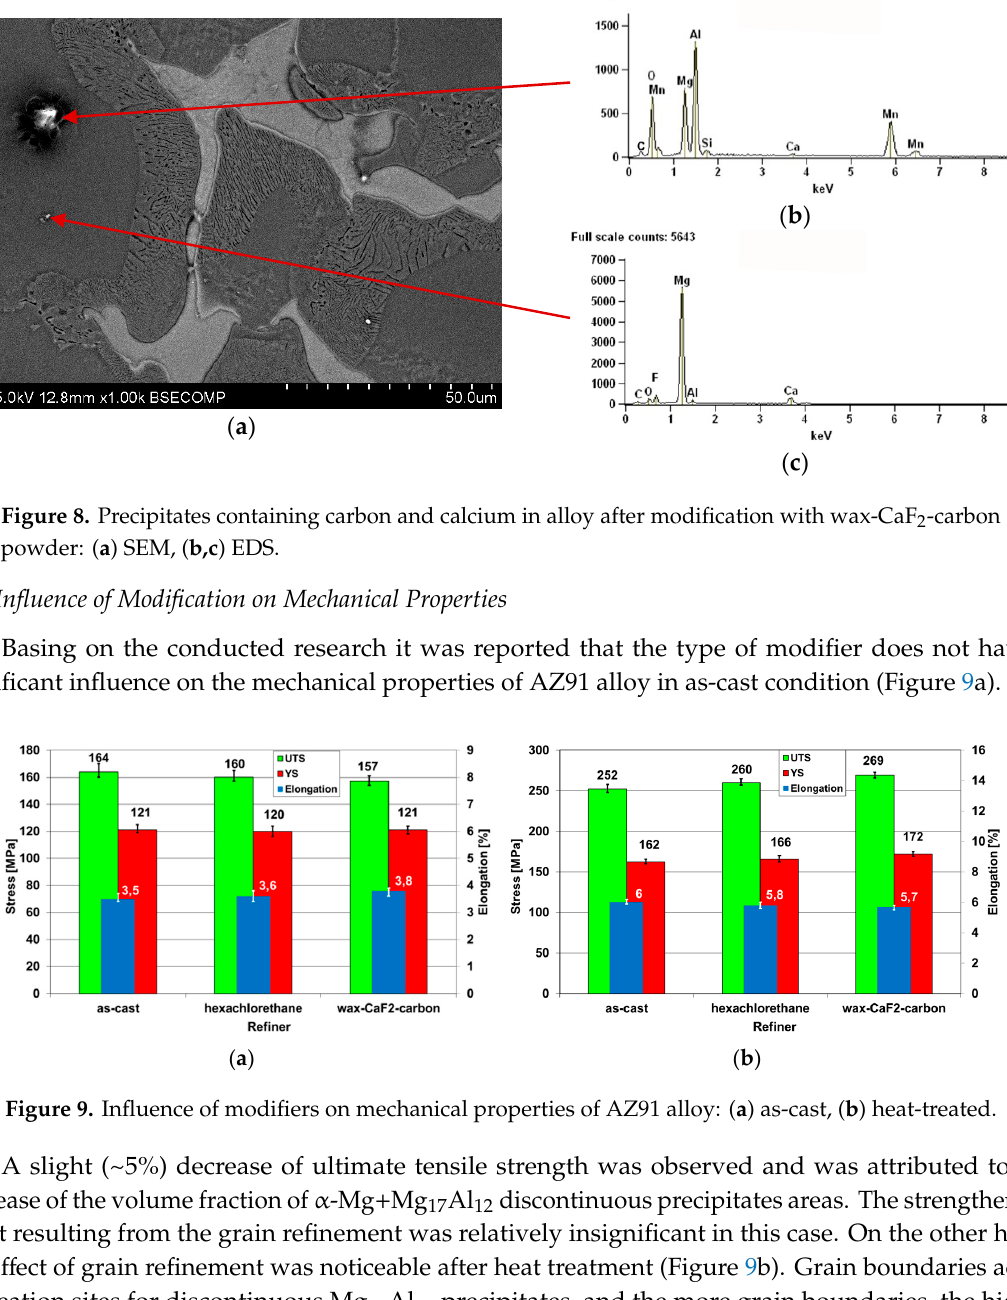
Figure 9. Influence of modifiers on mechanical properties of AZ91 alloy: ( a ) as-cast, ( b ) heat-treated.